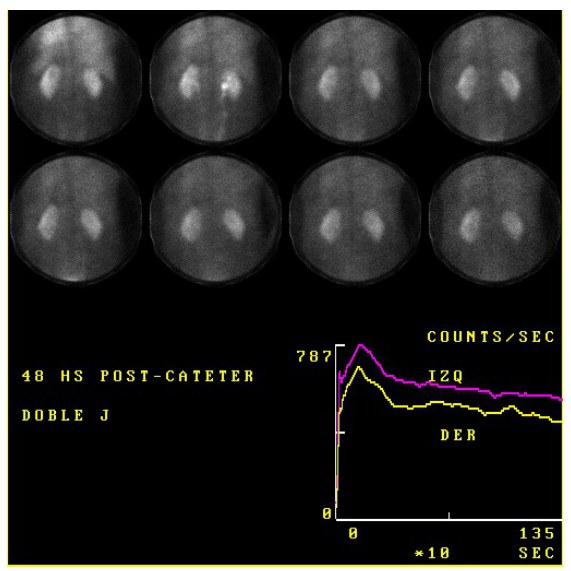
FIGURE 9. Renal scintigraphy 48 hs. post-catheter introduction (4/19/06). Normal